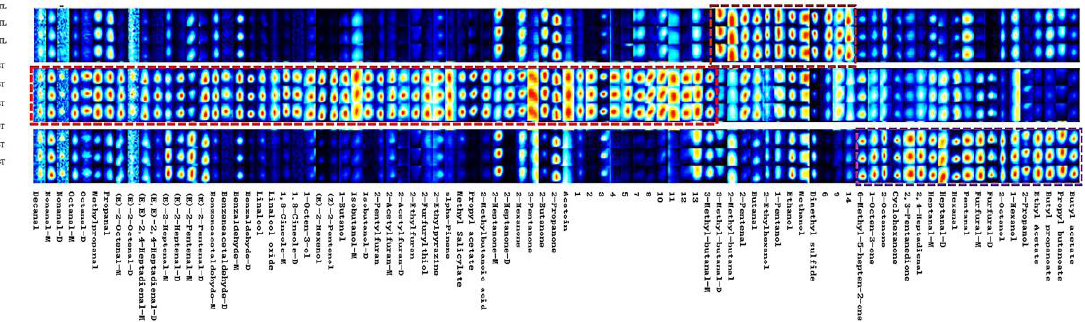
Figure 3. Gallery plot fingerprint of different teas by GC-IMS. The compounds with higher content are framed in the colored boxes: brown for FTL, red for BT, while/purple for GT.